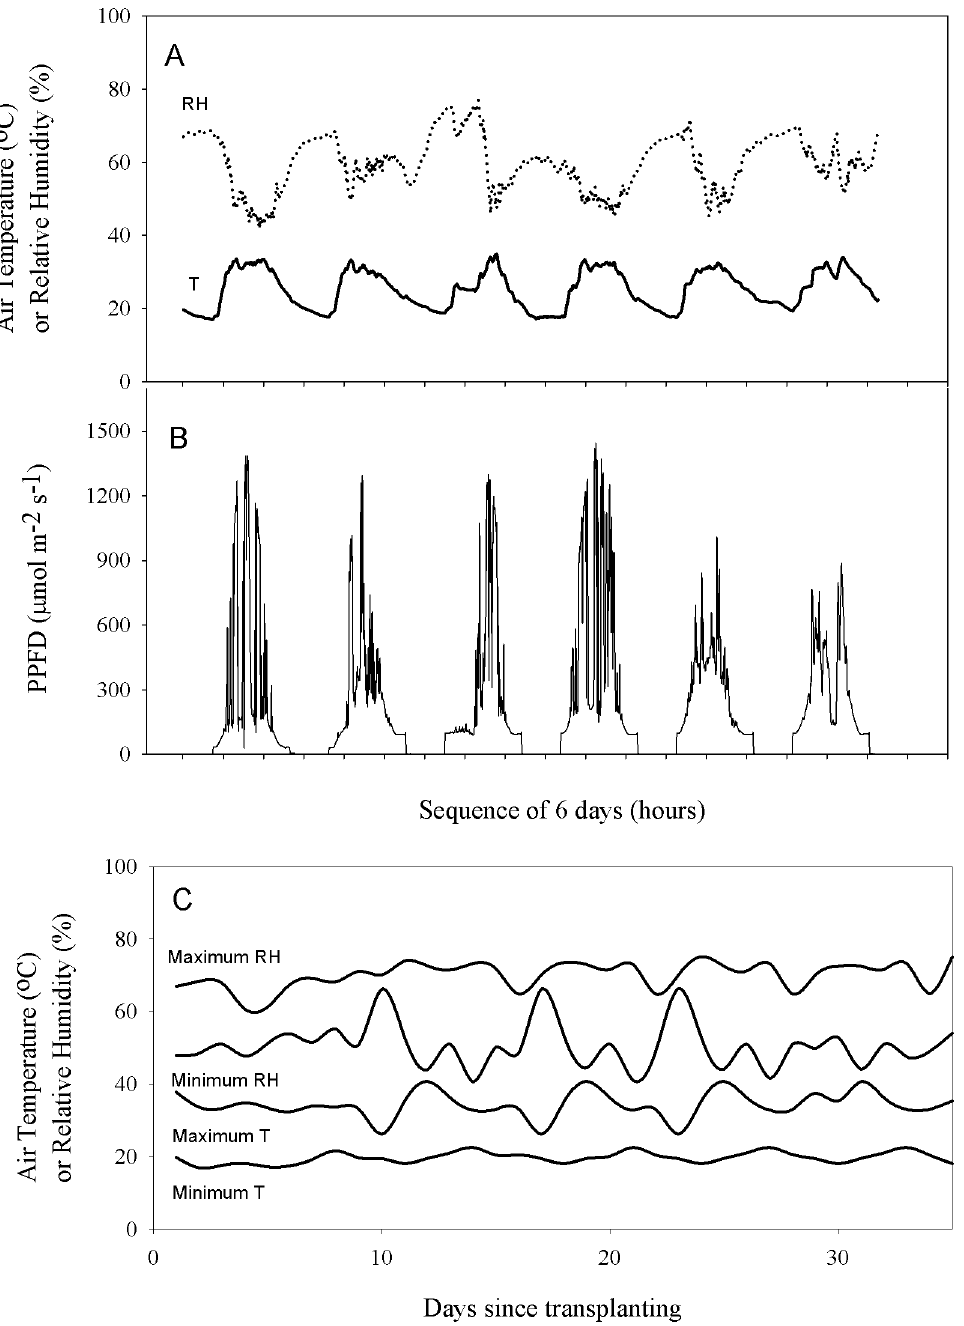
Fig. 1. The microclimatic conditions at canopy height in the growth room used for an experiment on grafted and non-grafted lines of tomato are shown. A) Six representative diurnal cycles of air temperature and relative humidity; B) Six representative diurnal cycles of photosynthetic photon flux density (PPFD); C) Daily maximum and minimum air temperature and relative humidity over the 30 day experimental period.